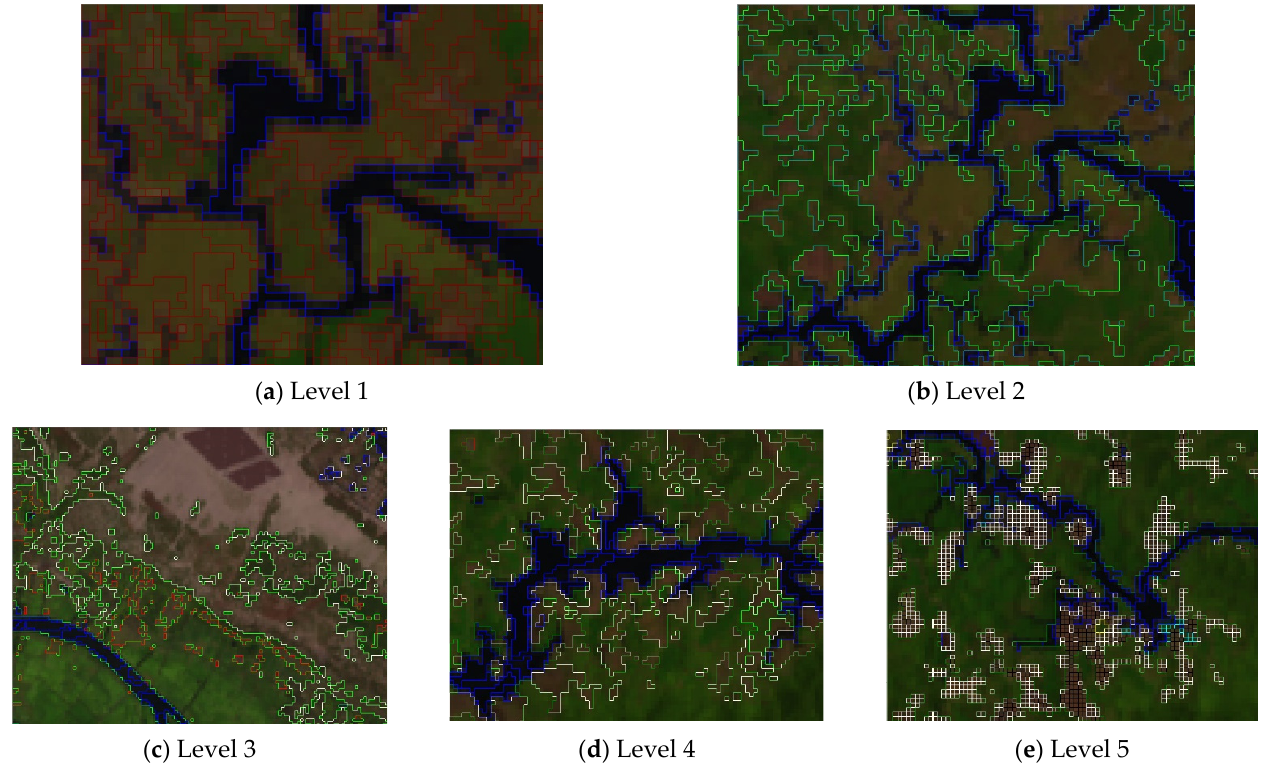
Figure 3. Segmentation levels of Landsat 8 OLI.